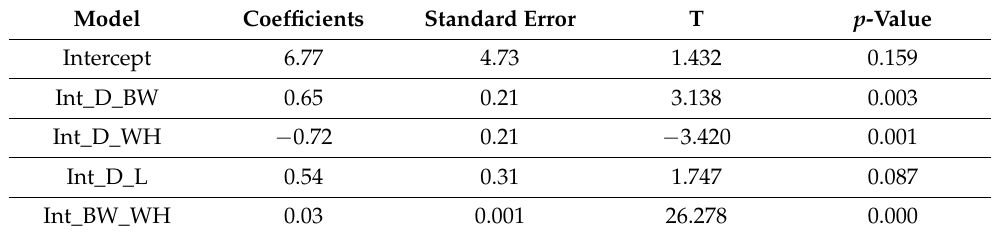
Table 6. Coefficients of stepwise backward regression for the dependent variable thoracic VI.